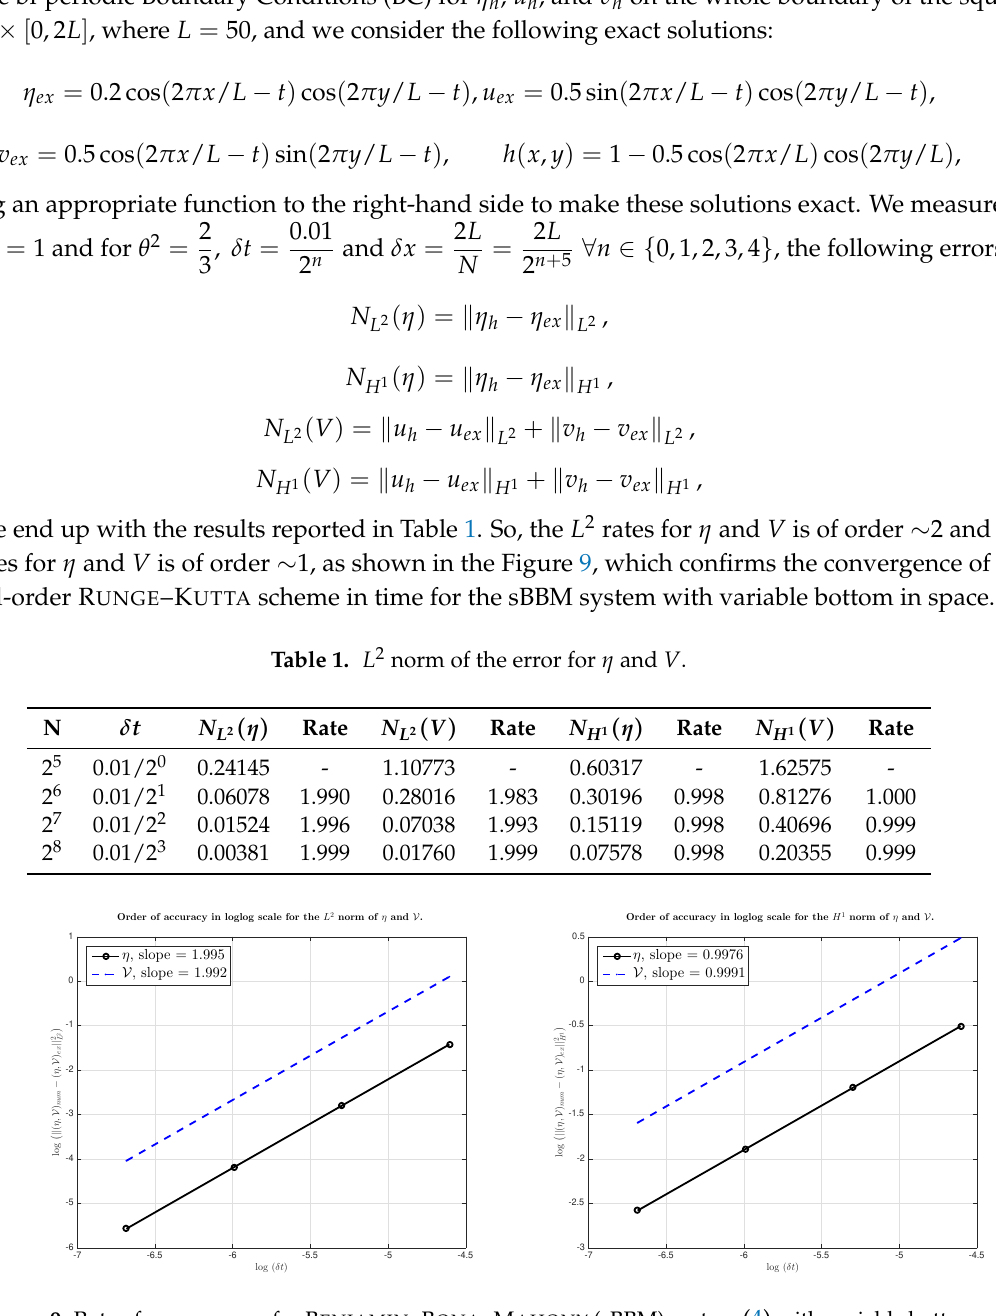
Figure 9. Rate of convergence for B ENJAMIN –B ONA –M AHONY (sBBM) system (4) with variable bottom in